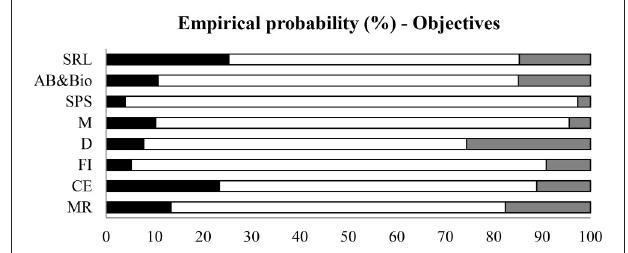
FIGURE 3 | Survey 1—AHP (Exploratory analysis): empirical probability to be first and to be last associated to the objectives according to stakeholders’ preferences, respectively, for ecological, pressure/impact, and economic components. SRL, Maintain safe level of reproductive potential; AB&Bio, Conserve abundance and biodiversity; SPS, Preserve the size structure of the fish populations; M, Monitoring the mortality; D, Reduce discards; FI, Monitoring the fishing intensity; CE, Improve cost efficiency; MR, Maximize